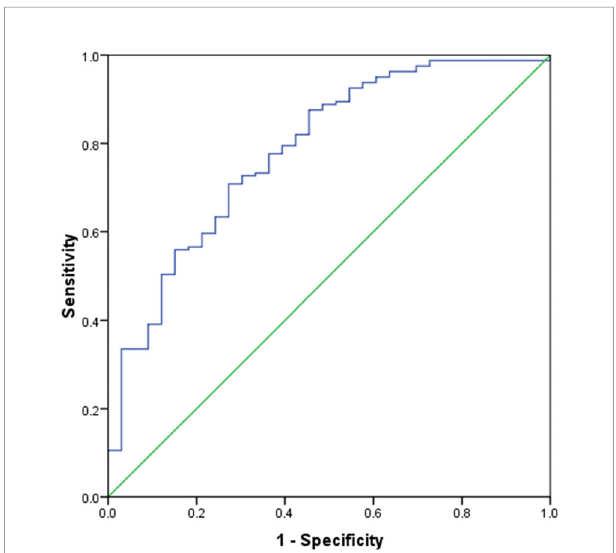
FIGURE 3 | Receiver operating characteristic curve analysisof predictive value of the multivariate logisticregression model.The area under the curve was